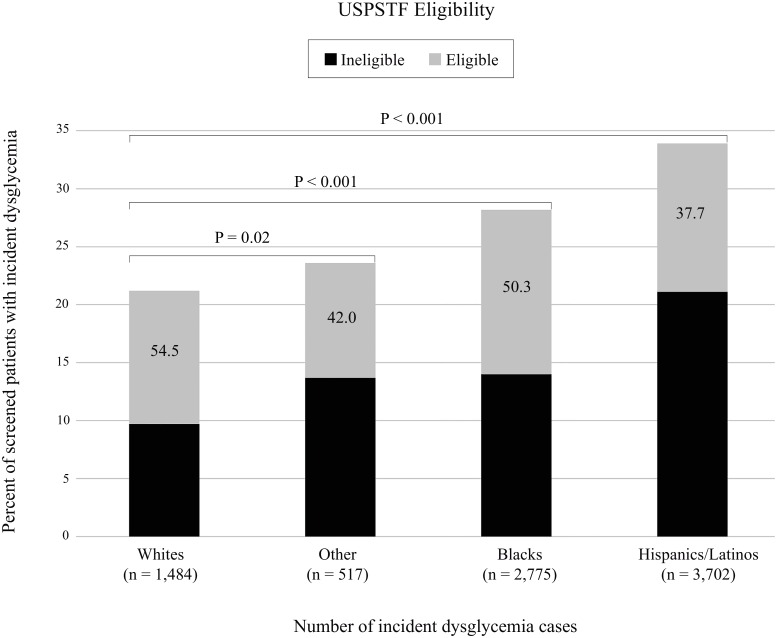
Development of clinically detected dysglycemia within 3 y among patients who received screening by race/ethnicity and USPSTF eligibility (n = 29,946).
P-values were derived from pairwise comparisons of USPSTF eligibility among racial/ethnic groups using Chi-square tests. Numbers displayed within the bars represent the probability of being eligible for screening among those who developed dysglycemia (i.e., sensitivity). USPSTF, US Preventive Services Task Force.